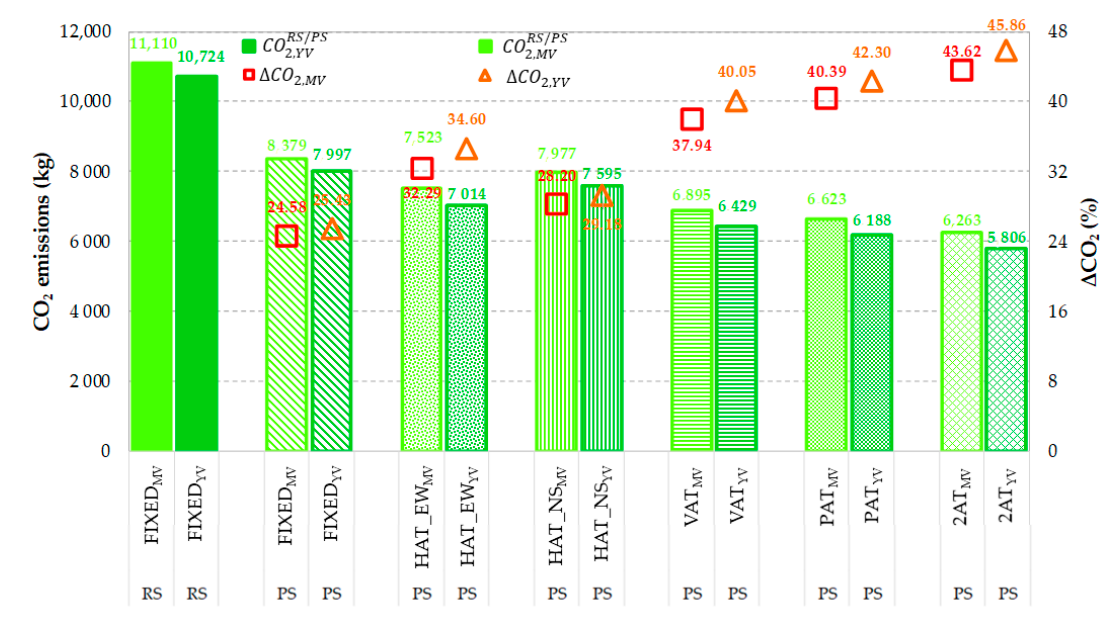
Figure 12. Environmental analysis on annual basis in both Scenario_MV and YV.